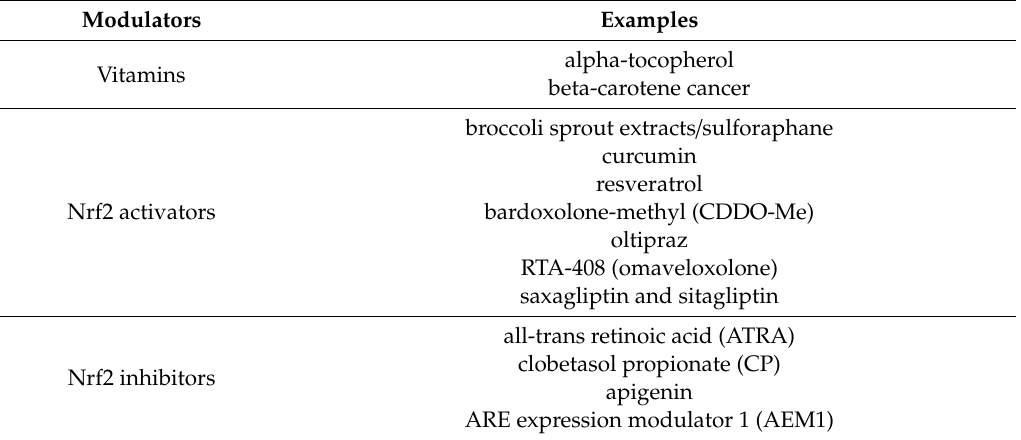
Table 6. Summary of the described antioxidant defense mechanisms in cancer incidence and anticancer